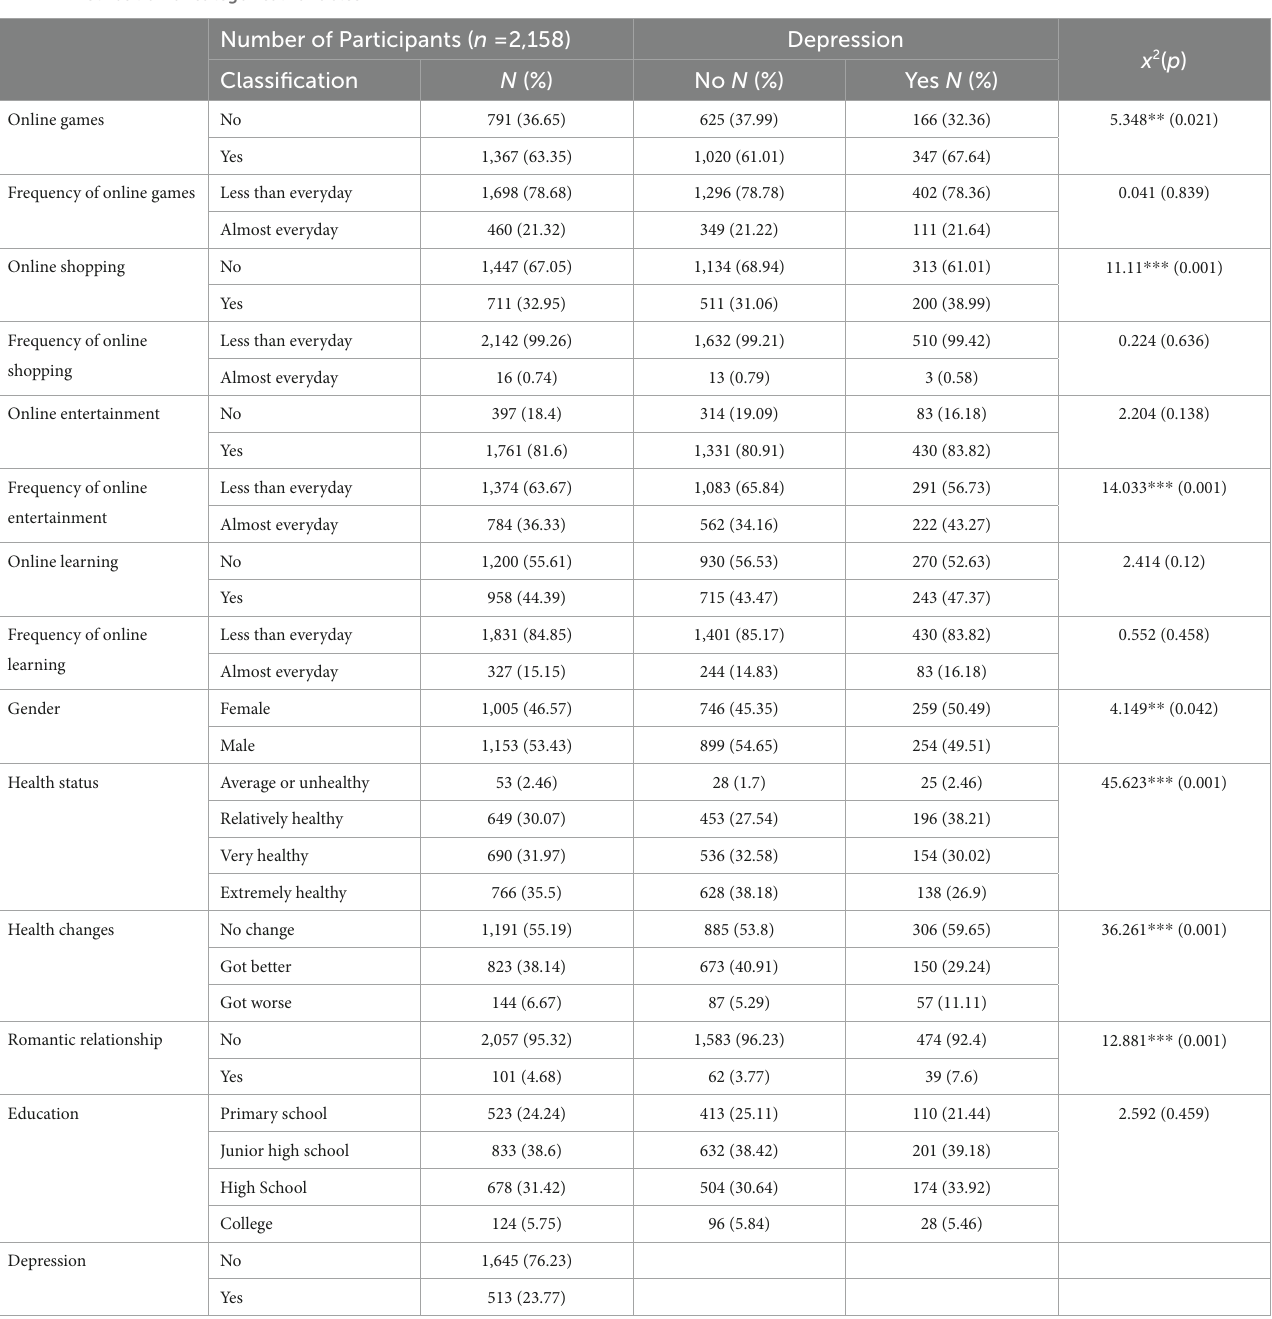
TABLE 1 Distribution of categorical